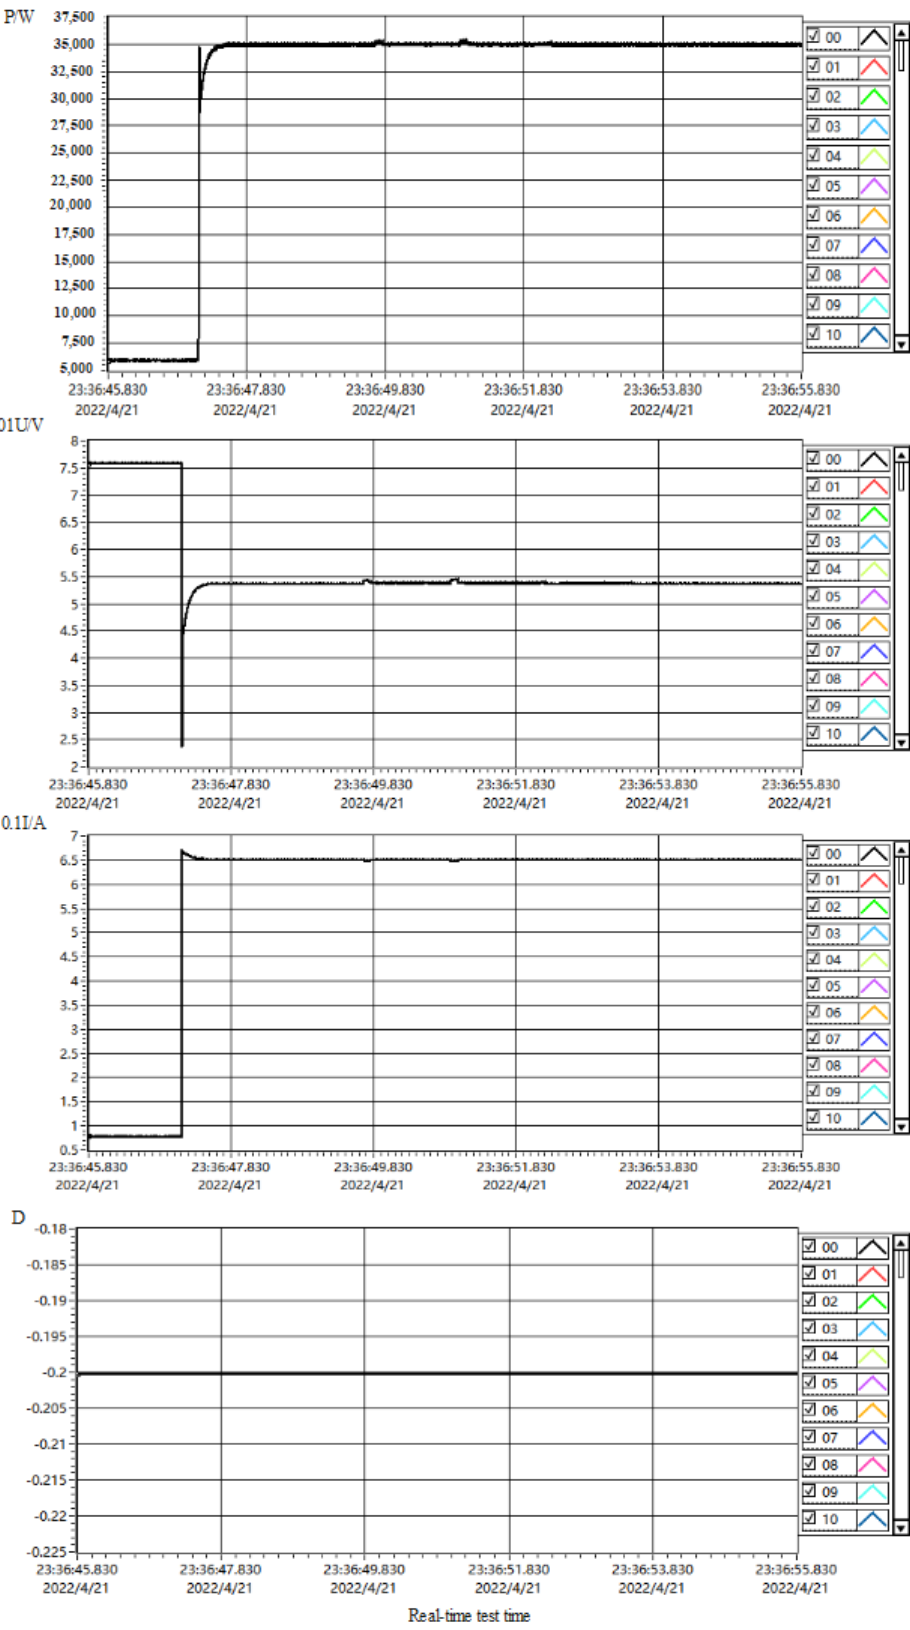
Figure 16. SSA output curves based on real-time simulation platform.